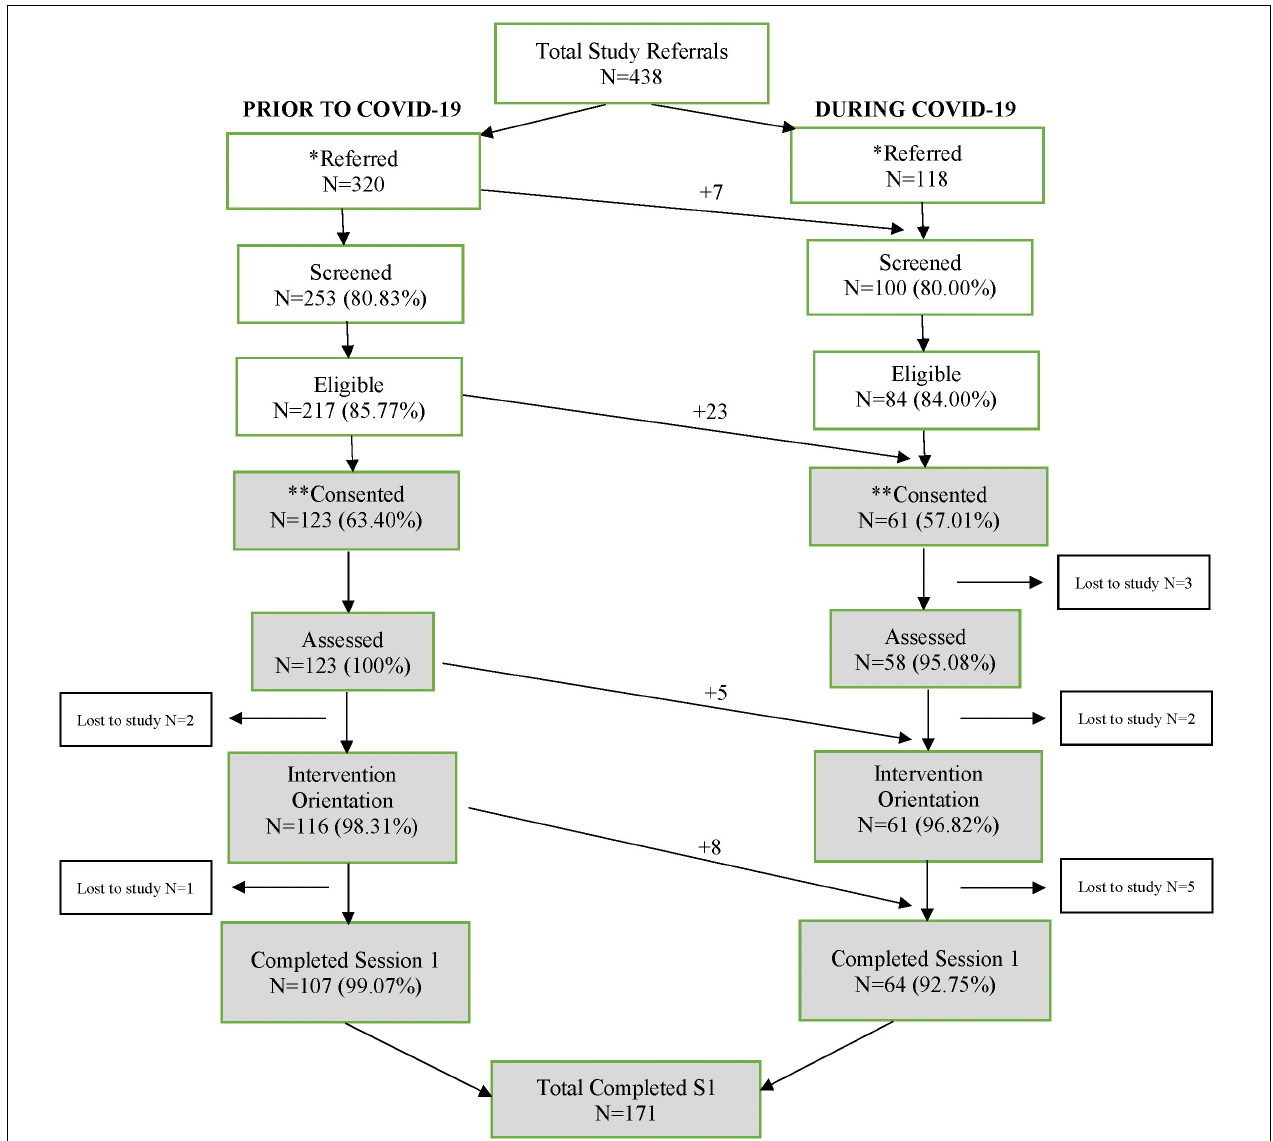
FIGURE 1 | Referral to intervention engagement progression. Arrows from left to right signify participants moving from pre-pandemic experience into pandemic experience at each study progression point. *Prior to COVID, 320 mothers were referred over a 22-month period resulting in an average of 14.5 referrals per month, equivalent to less than an average of two referrals per day. During COVID, 118 mothers self-referred in response to a provider text blast. Over a 3-day period, 118 referrals are equivalent to an average of 39 mothers per day. Hence, mothers referred at a relative daily rate of 19.5 times higher during COVID as compared to non-covid. Referral was closed after this 3-day referral period. **It was not possible to consent all referred, screened, and eligible mothers during COVID because this number exceeded the number of open slots for targeted enrolment. Prior to COVID, a 2.43% of participants were lost to the study after consent as compared to 16.39% lost during pandemic. Hence, 6.75 times more mothers were lost to the study during the